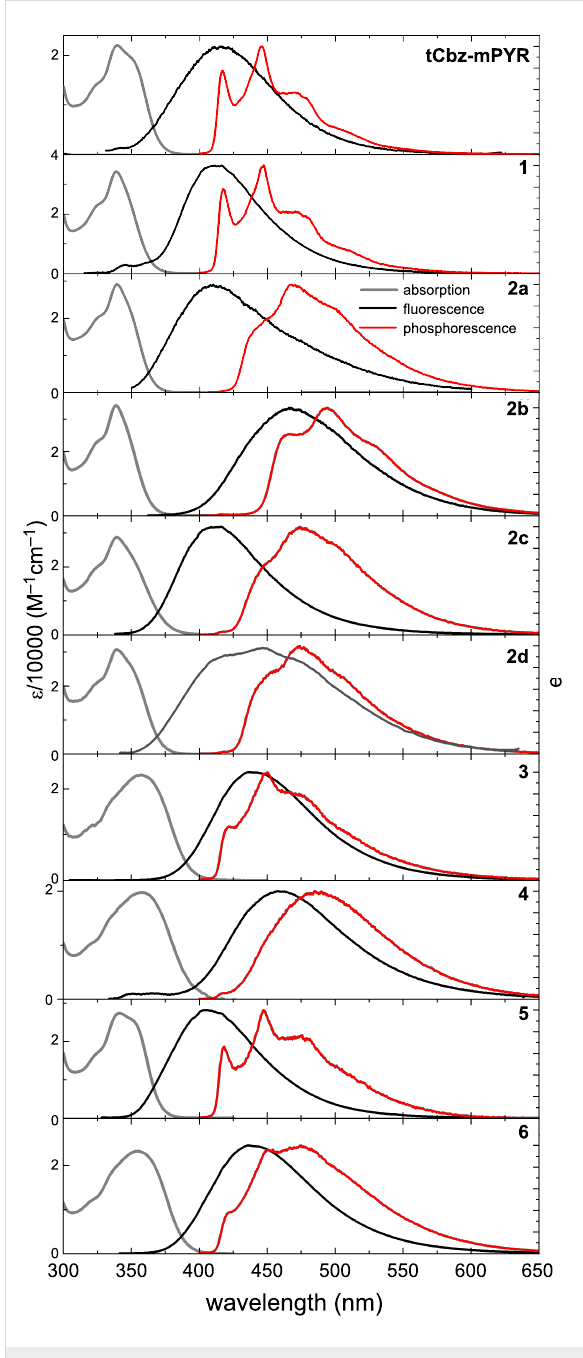
Figure 3: Absorption (grey lines), fluorescence (black lines) and 10K phosphorescence (red lines) spectra of carbazole–pyrimidine TADF compounds. 10 − 5 M toluene solutions were used for absorption mea- surements, while 1 wt % PMMA films were used for emission mea-